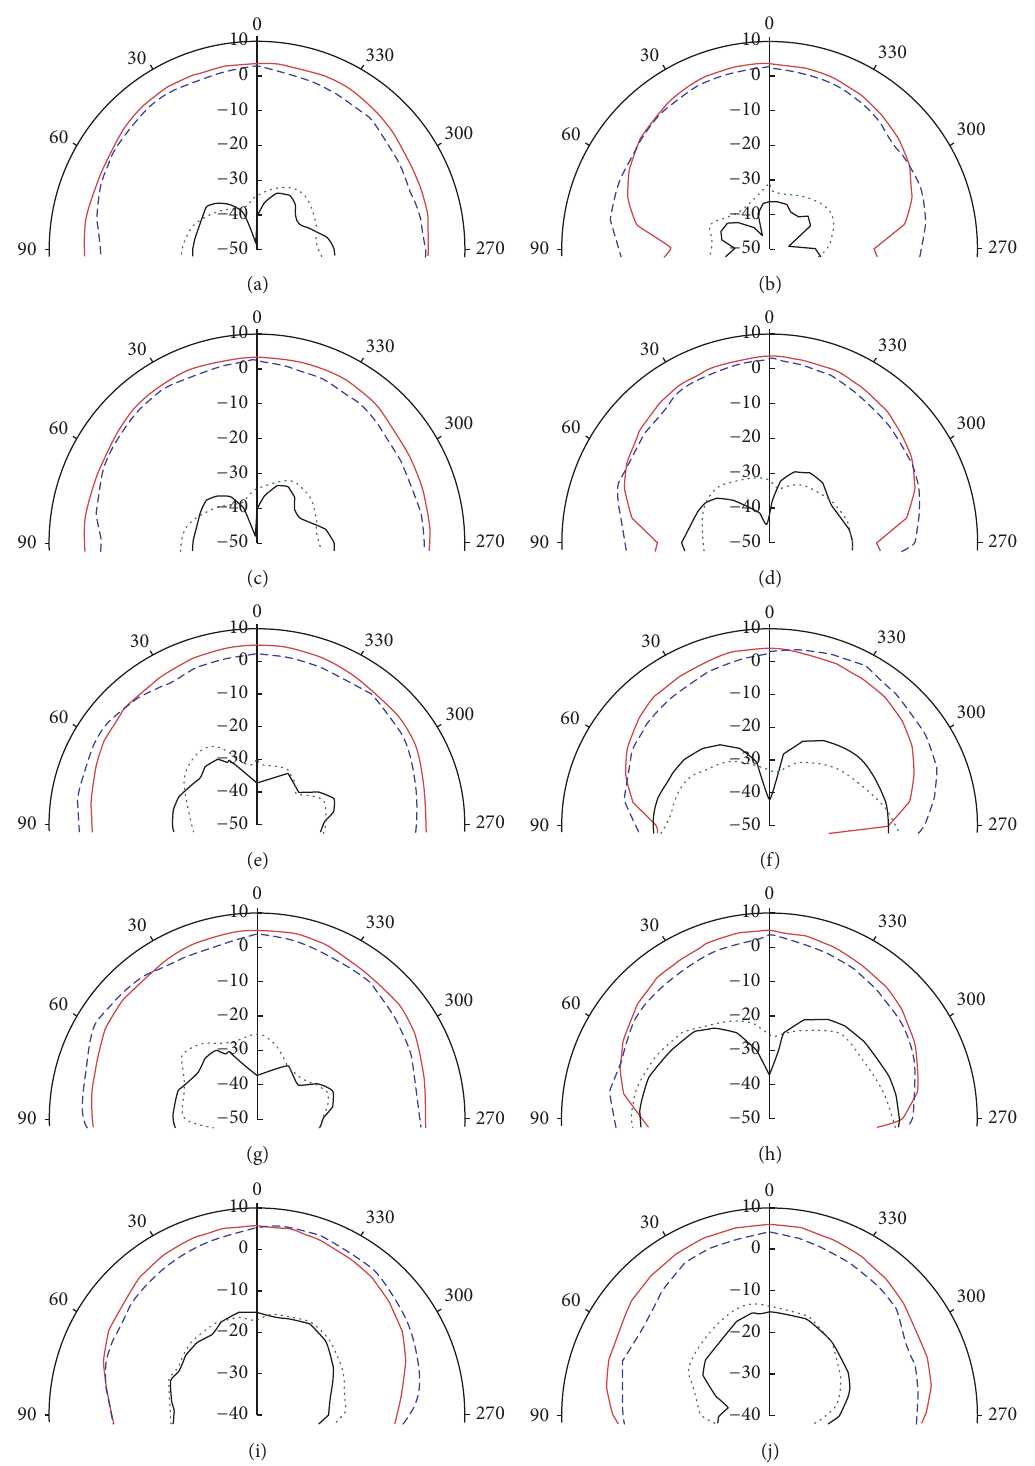
Figure 17: Simulated and measured co- and cross-polarization patterns, red solid line: simulated copolarization, blue dotted line: measured copolarization, black solid line: simulated cross-polarization, and green dotted line: measured cross-polarization. (a) 𝐸 -plane at 1.77 GHz, (b) 𝐻 -plane at 1.77 GHz, (c) 𝐸 -plane at 1.9 GHz, (d) 𝐻 -plane at 1.9 GHz, (e) 𝐸 -plane at 2.05 GHz, (f) 𝐻 -plane at 2.05 GHz, (g) 𝐸 -plane at 2.6 GHz, (h) 𝐻 -plane at 2.6 GHz, (i) 𝐸 -plane at 3.68 GHz, and (j) 𝐻 -plane at 2.68